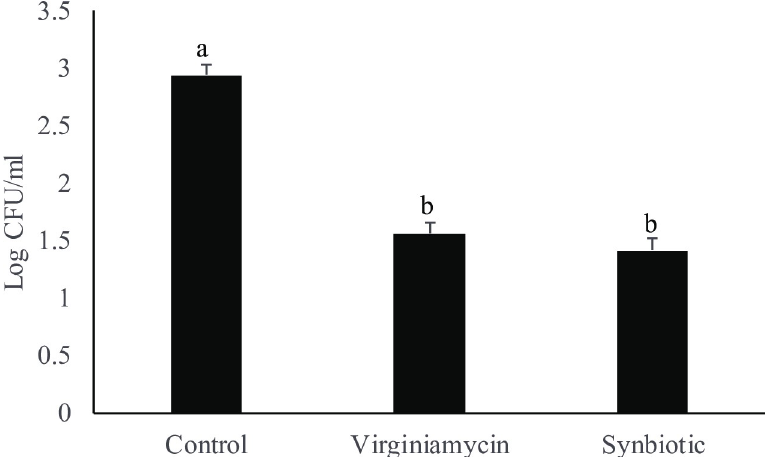
Fig 3. Effect of synbiotic supplementation on chilled carcass S . Enteritidis rinsate load post-Salmonella infection in broiler birds. Birds were fed either basal diet (Control) or supplemented with 20 mg/Kg feed Virginiamycin (antibiotic) or 0.05% synbiotic product from day-of-hatch through 42d of age. At 21 d of age, birds were challenged with 1 X 10 9 CFU of S . Enteritidis . At 21 d post-infection, the carcass S . Enteritidis most probable number (MPN) was analyzed by plating on XLT agar and expressed as log MPN/ml. Bars ( ± SEM) with no common superscript ( a, b ) differ significantly (P < 0.05). n = 8.